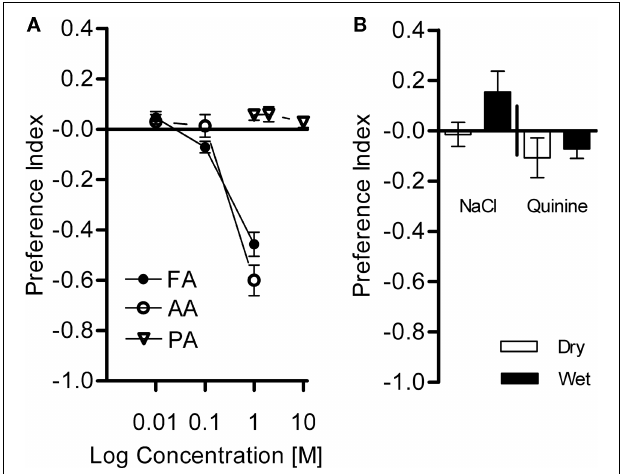
FIGURE 10 | Aversive visual associative memory. Memories of fl ies that were trained with formic acid or acetic acid instead of sugar. The same training protocol was applied as for appetitive conditioning. Conditioned avoidance was tested in the presence or absence of the respective reinforcer (white or black bars, respectively). Signifi cant memory was only found with formic acid when formic acid was present during the test [one-sample t -test, t = 3.714, = 16.73, P < 0.001; FA (39) (7) P < 0.01]. No signifi cant memory could be detected without a reinforcer in the test or using acetic acid as reinforcer [one-sample t -test, FA No US @ Test: = 1.134, (7) t = 0.6058, P > 0.05; AA US @ Test: t = 0.2170, P > 0.05; AA No US @ (39) (19) Test: